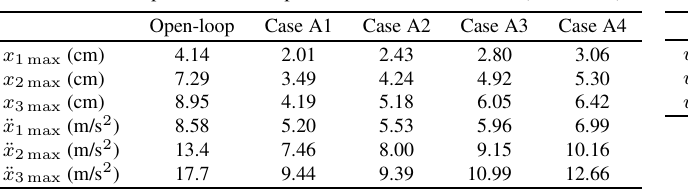
Table 1 The maximum responses of the displacements and accelerations ( τ = 25 ms)